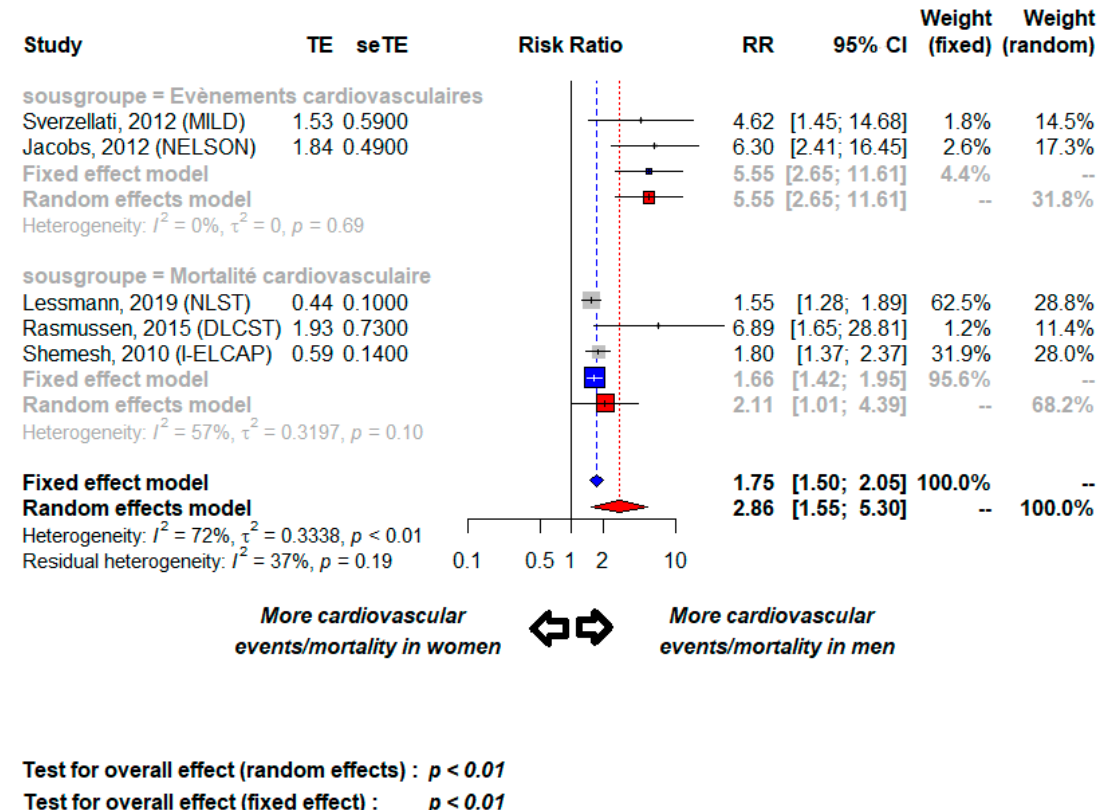
Figure 4. Cardiovascular events and mortality according to sex; TE, estimate of treatment effect, e.g., log hazard ratio or risk difference; seTE, Standard error of treatment estimate; RR, relative risk. Table 4. Frequency of coronary artery calcifications (CACs) according to sex, when available.